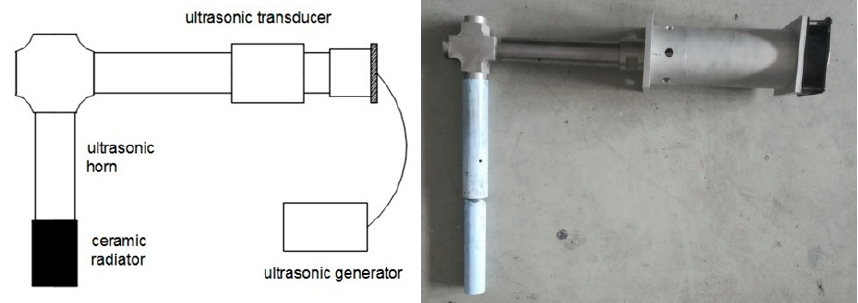
Figure 1. L-Shaped ultrasonic rod device.